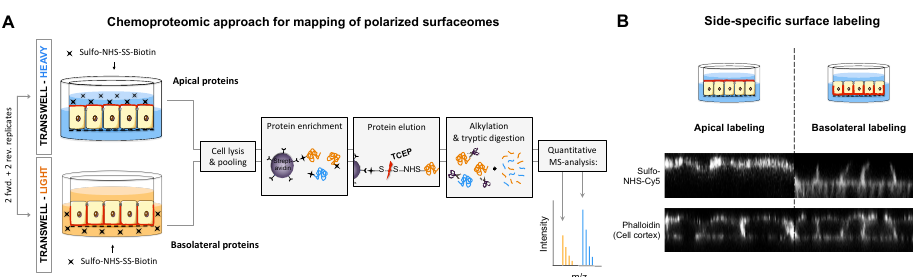
Figure 1. Chemoproteomic approach to map polarized protein distributions across the apicobasal surfaceome. ( A ) Workflow: MDCK cells are metabolically labeled with light and heavy isotopes of amino acids using SILAC and polarized in Transwell™ cultures. Apical and basolateral surface proteins are tagged in differentially labeled SILAC cultures using a sulfo-NHS-SS-biotin conjugate. Heavy and light cell lysates are mixed, and biotinylated surface proteins are enriched on streptavidin beads. Enriched proteins are eluted by reduction of the disulfide bond of the biotin conjugate, alkylated and digested with trypsin, and quantified by mass spectrometry. Proteins derived from the apical and basolateral surface are quantitatively compared based on their heavy-to-light ratio. Experiments were conducted in quadruplicates, including two forward and two reverse SILAC replicates. ( B ) Side-specific protein labeling with sulfo-NHS-Cy5 on the apical and basolateral surfaces of filter-grown MDCK cells was confirmed by confocal microscopy imaging. Phalloidin staining of F-actin was used to visualize the cell cortex as a